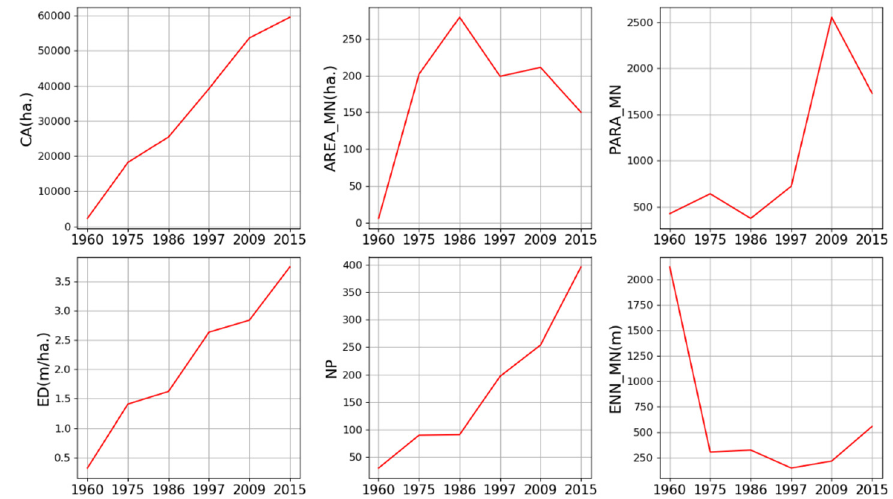
Figure 3. Temporal changes in landscape metrics in the FDB during 1960–2015.